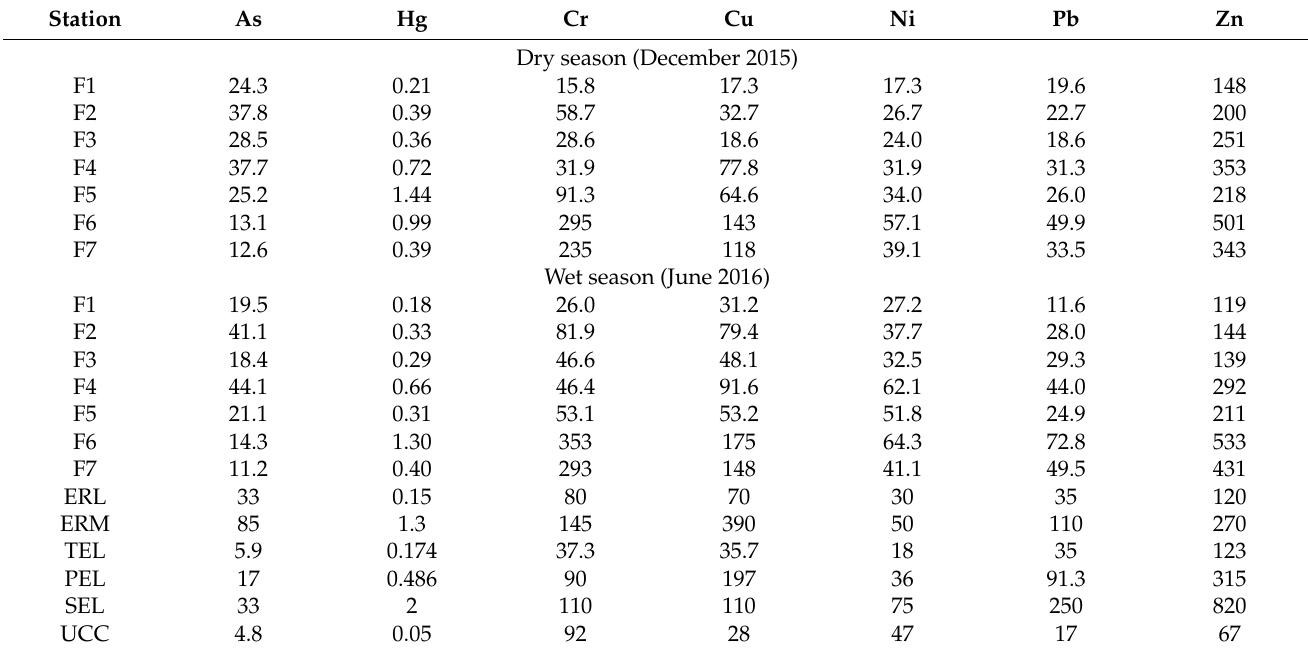
Table 1. The concentrations (mg/kg) of heavy metals (As, Hg, Cr, Cu, Ni, Pb, Zn) in the sediments of Fengshan River in dry and wet